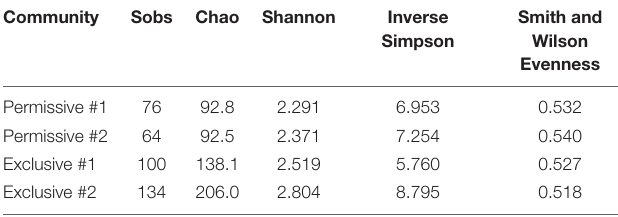
statistically significant positive correlation with the Salmonella cecal abundance ( P < 0.02).